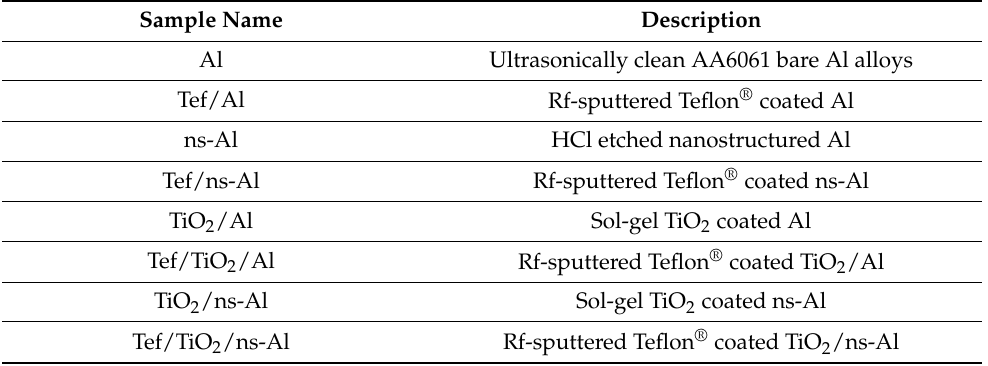
Table 1. Information on samples tested for superhydrophobicity and icephobicity.